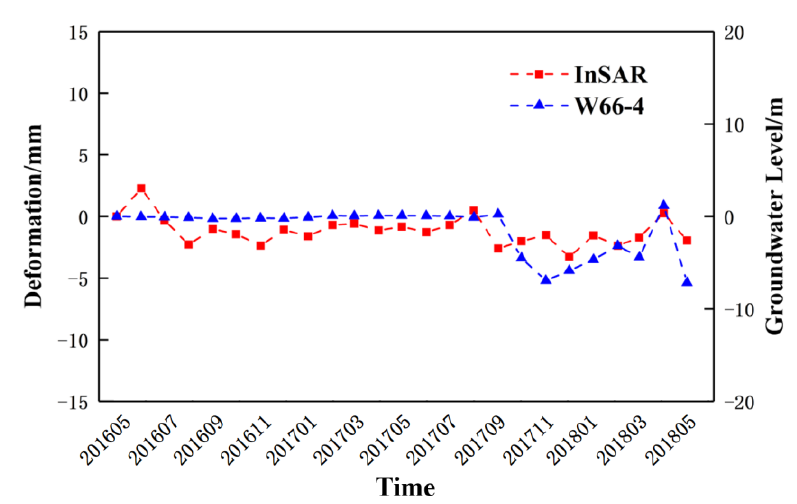
Figure 12. The relationship between PSInSAR derived deformation time series and groundwater level at well W66-4.